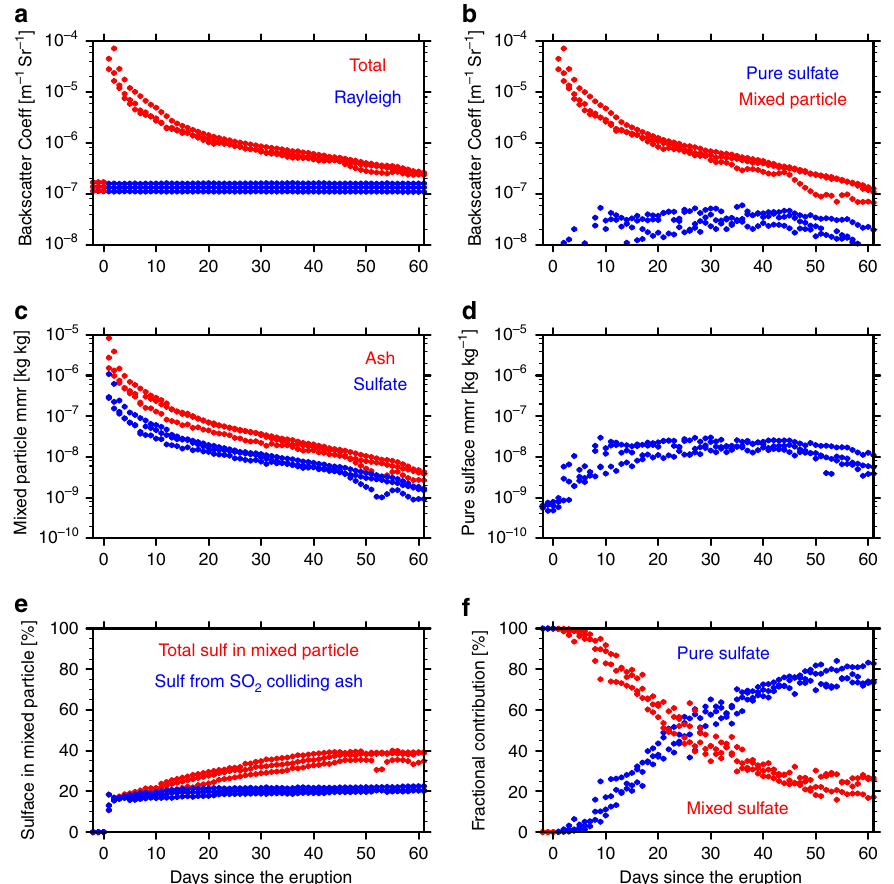
Fig. 7 The composition evolution from the SO2onAsh case. The data are picked from the maximum total backscatter at three different pressure levels from 72 to 52 hPa. a the maximum total backscatter (aerosol + Rayleigh) in red and Rayleigh backscatter in blue; b the backscatter contribution from the mixed particle and pure sulfate respectively; c the mass mixing ratio of ash and sulfate (H2SO4 + water) inside the mixed particles; d the mass mixing ratio of pure sulfate; e the weight percent of sulfate inside the mixed particle. The blue dots are the sulfate coming from SO2 reacting on ash and the red dots are the total sulfate percentage (blue dots + sulfate from coagulation/growth); f the weight percent of pure sulfate in total sulfate (blue) and the weight percent of sulfate in mixed particle in total sulfate (red). The Base case compositions are shown in Supplementary Fig.